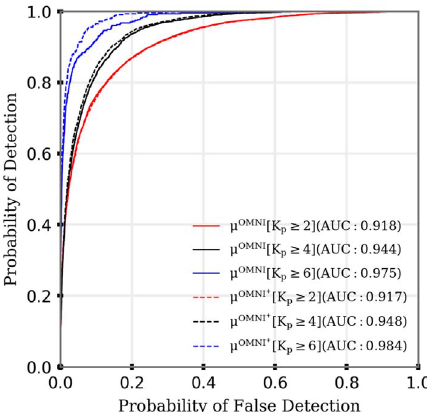
Fig. 11. Receiver operating characteristic (ROC) curves showing the relative performance of individual the storm forecasting model l OMNI (represented by solid curves) and l OMNI þ (represented by dashed curves) with different storm intensity levels (for K p (cid:1) 2, 4, and